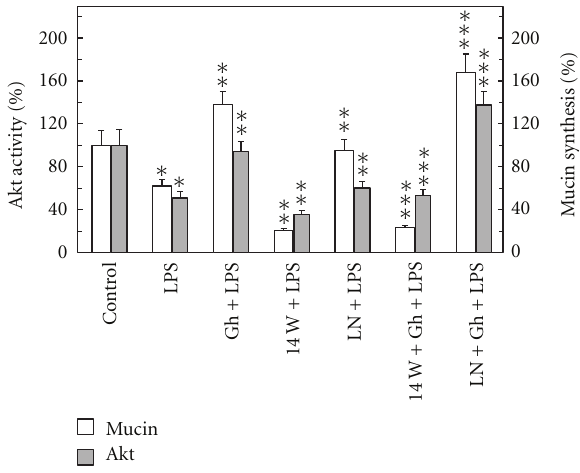
Figure 5: E ff ect of iNOS inhibitor, 1400W, and cNOS inhibitor, L- NAME, on the ghrelin (Gh)-induced changes in Akt kinase activity and mucin synthesis in the acinar cells. The cells, preincubated with 30 μ M 1400W (14W) or 200 μ M L-NAME (LN), were treated with Gh at 0.6 μ g/mL and incubated for 16h with the LPS at 100ng/mL, in the presence of [ 3 H]glucosamine as a marker of mucin synthesis. Values represent the means ± SD of five experiments. ∗ P < . 05 compared with that of control. ∗∗ P < . 05 compared with that of LPS alone. ∗∗∗ P < . 05 compared with that of Gh + LPS.